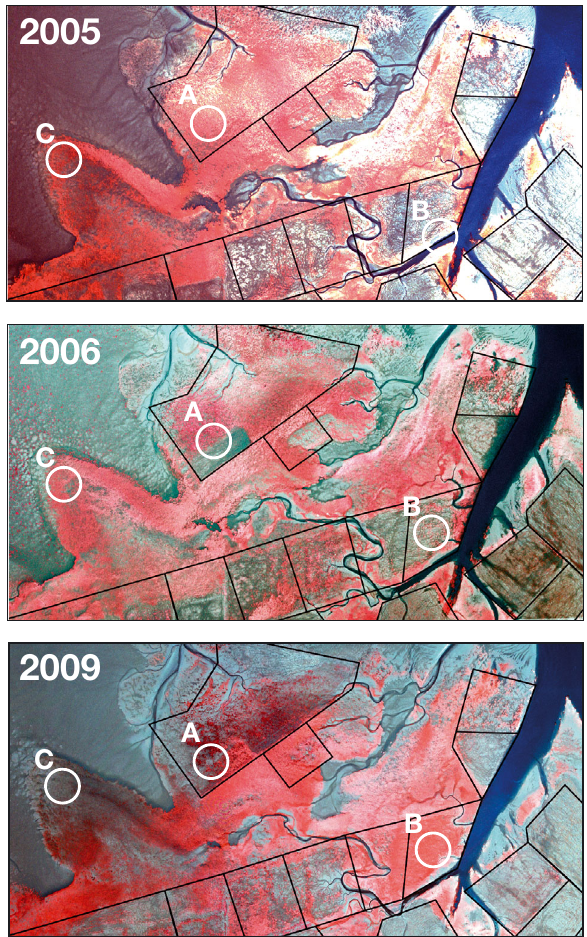
Fig. 4. Aerial infrared photographs of tideflats in northern Willapa Bay from 2005, 2006, and 2009, with oyster aquacul- ture beds outlined in black. Note changes over time, with vegetation (red) evident on some beds (A) in 2005, absent on others (B), and changing over time in 2006 and 2009. Vege- tation also changed in areas outside aquaculture beds